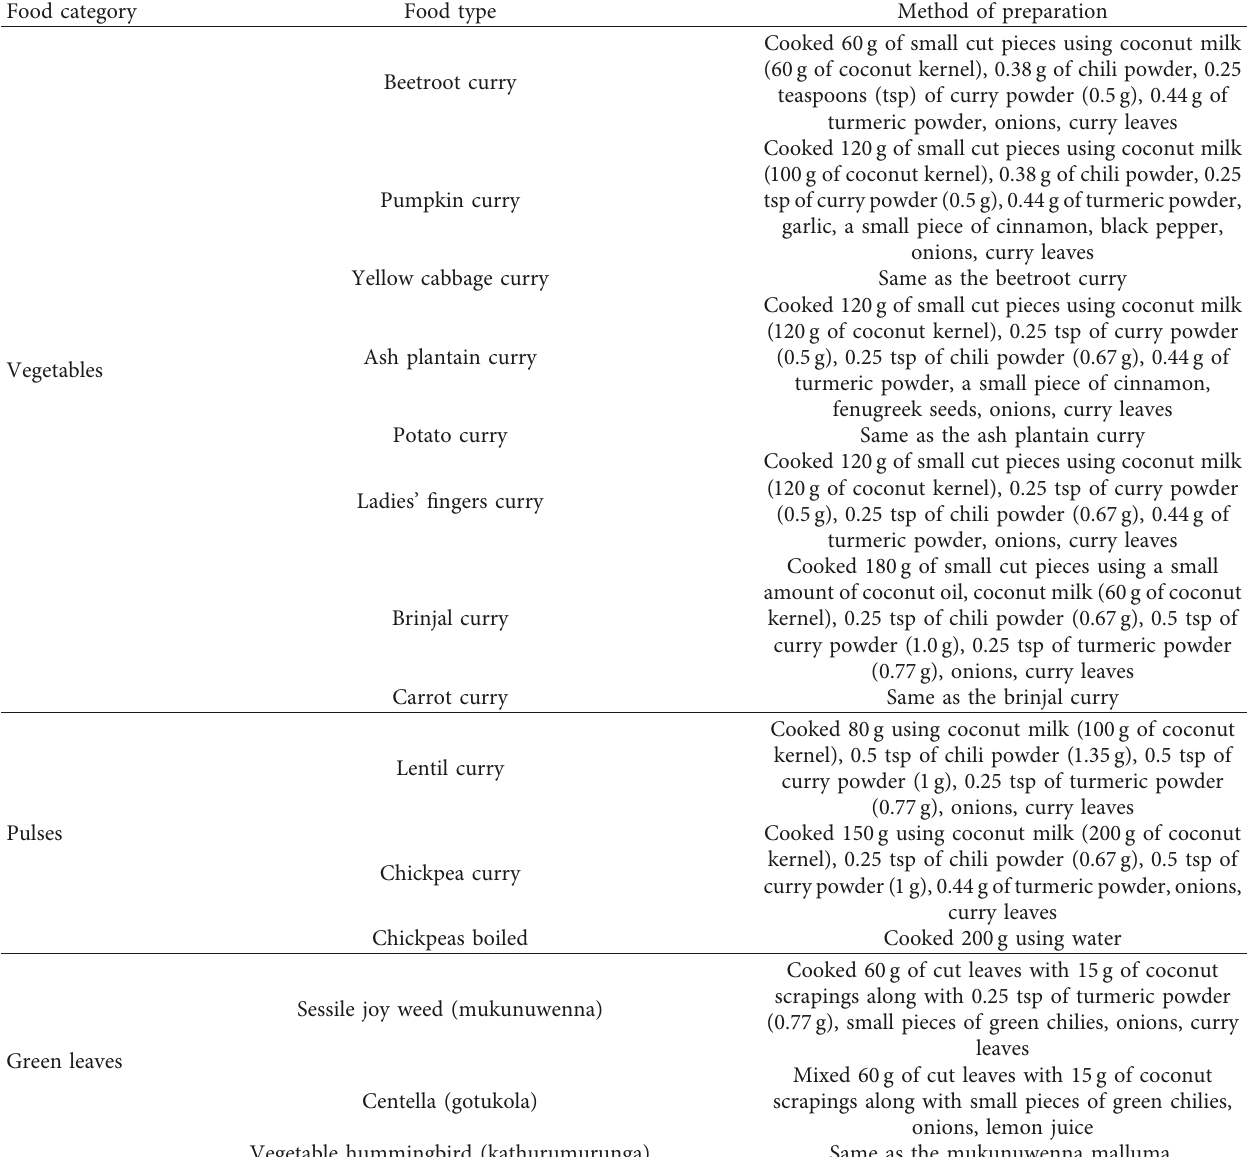
Table 2: Commonly consumed foods by the study population and their respective methods of